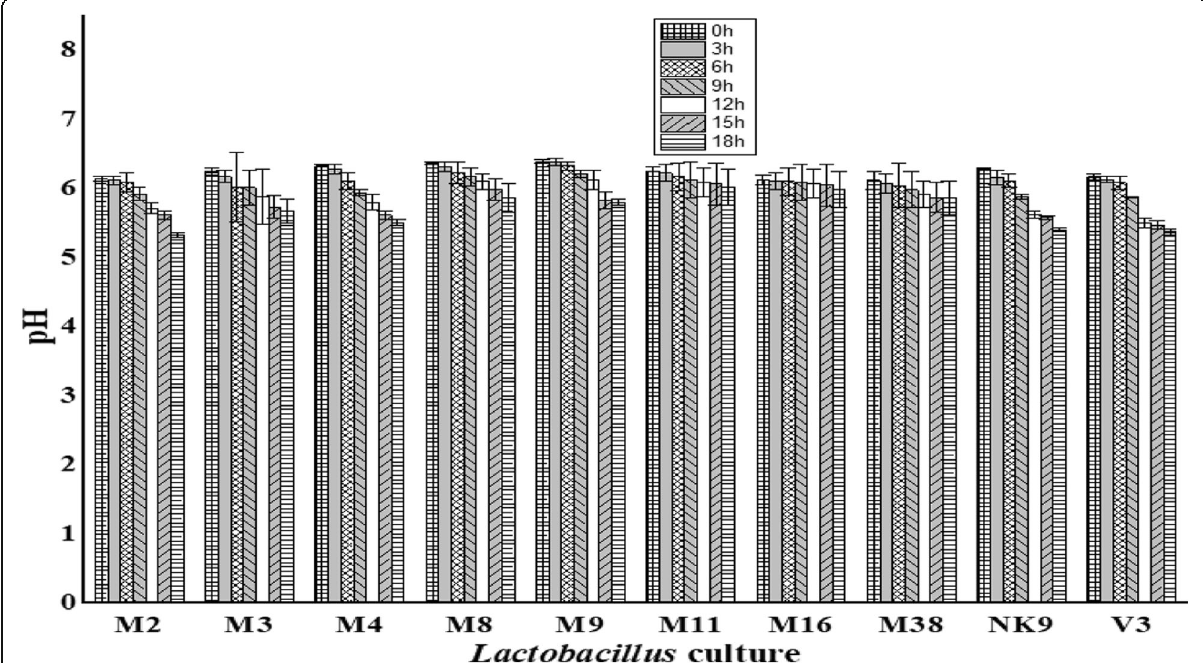
Fig. 1 Change in pH of lactic cultures incubated for different hours at 37 °C in soy milk